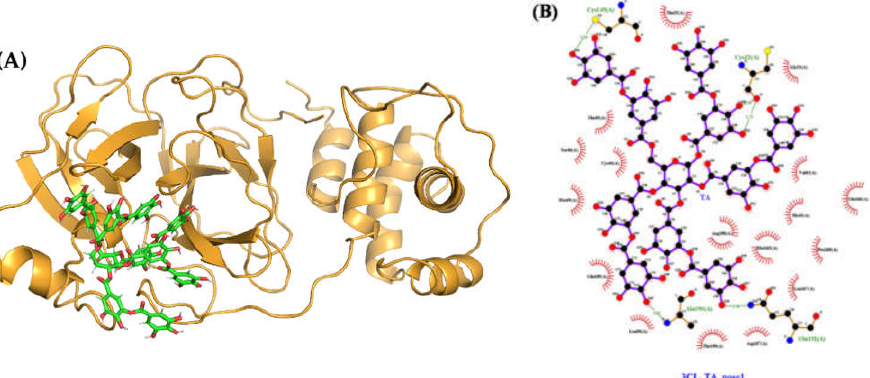
Figure 11. Molecular structures after 1000 ns of MD: ( A ) TA/3CLpro complex (pose 1, MMPBSA binding free energy of −65 kcal/mol); ( B ) ligand interaction map. The contact map of TA with 3CLpro is shown from the center of the biggest cluster computed on the convergence interval using the protein backbone atoms and ligand non-hydrogen atoms. The contacts, defined by a distance smaller than 0.40 nm between the ligand and the protein, are shown as red arcs. The interaction map is generated using LigPlot [50,51].